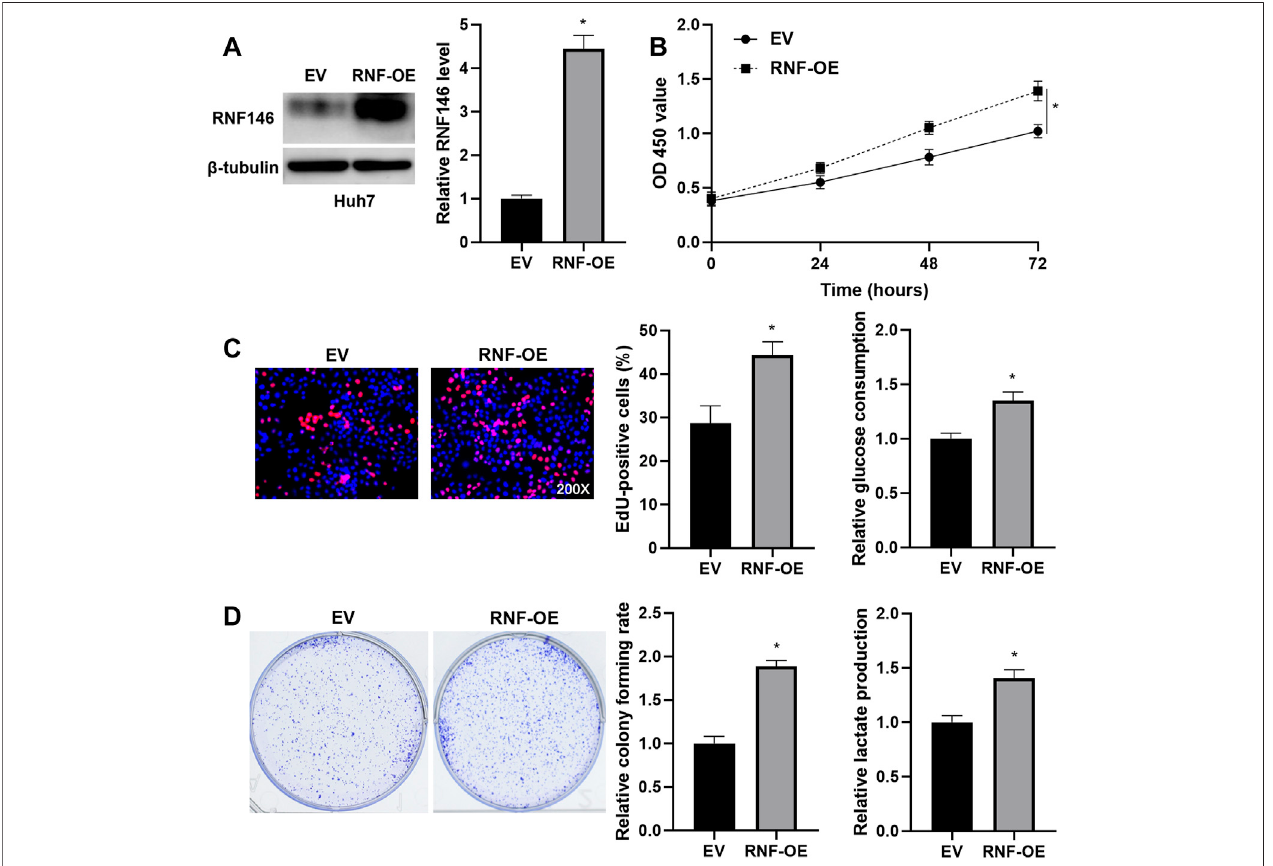
FIGURE 4 | RNF146 overexpression promotes the proliferation and glycolysis of Huh7 cells. (A) The pcDNA3.1/RNF146 (RNF-OE) and empty vector (EV) were transduced into Huh7 cells. WB wasperformed to determine the RNF146 protein level. (B) CCK-8, (C) EdU, (D) colony formation, E glucose consumption and F lactate production assays were performed to detect the proliferation, colony formation and glycolysis of Huh7 cells with or without RNF146 overexpression. * p < 0.05.